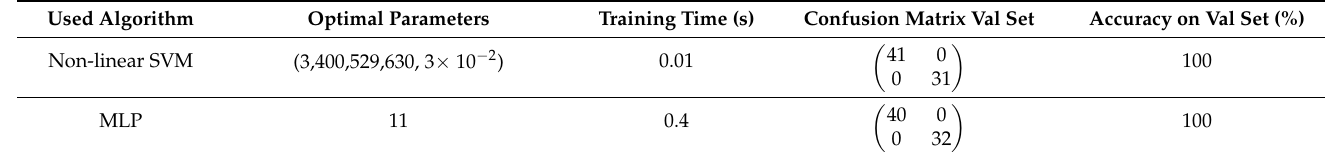
Table 5. The optimum pair (C*, γ *) for non-linear SVM and the optimal number of neurons ( N ∗ ) for MLP. Training time, confusion matrices, and accuracy obtained on the validation set for the two different ML algorithms trained with the Complex nature